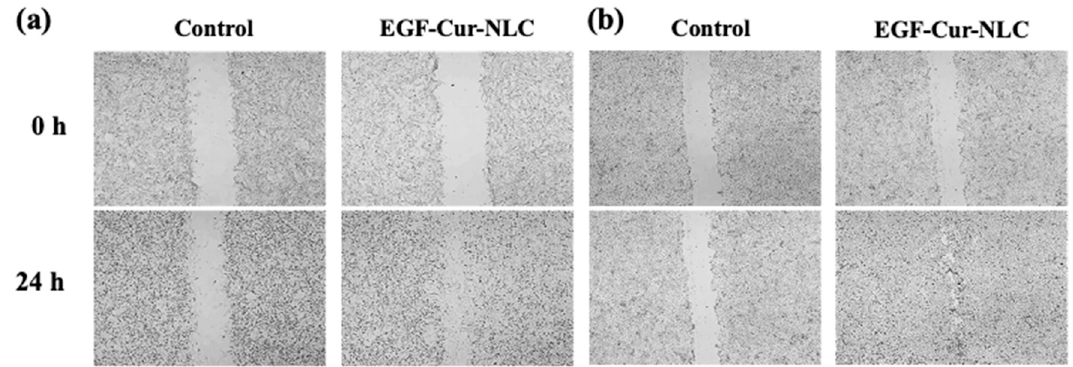
Figure 5. Cell migration assay for ( a ) NIH 3T3 fibroblast and ( b ) HaCaT keratinocytes.